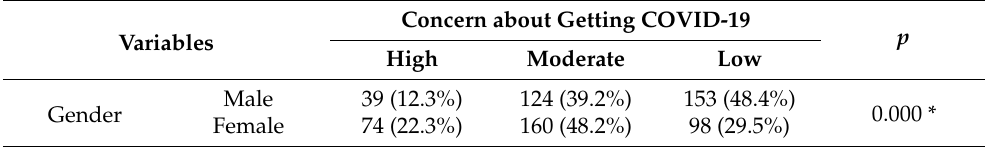
Table 3. Association between concern about the spread of COVID-19 and the gender of the participants.